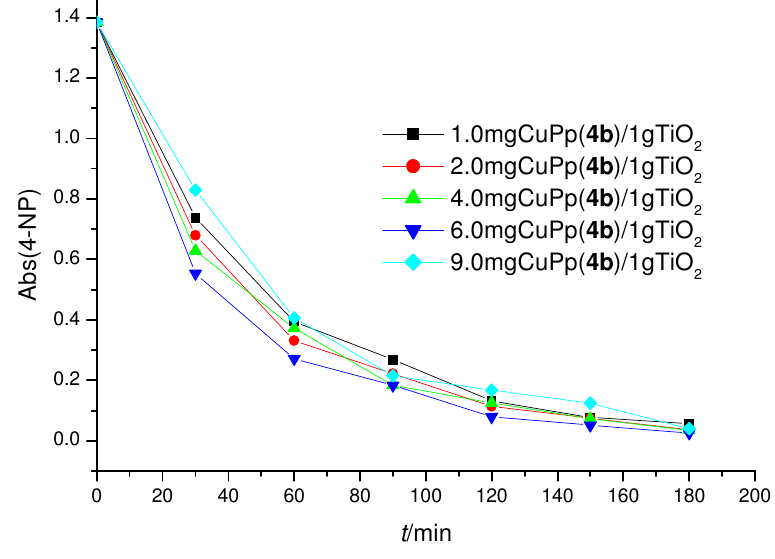
Figure 4. 4-NP concentration vs . irradiation time using different amounts of CuPp ( 4b )/TiO 2